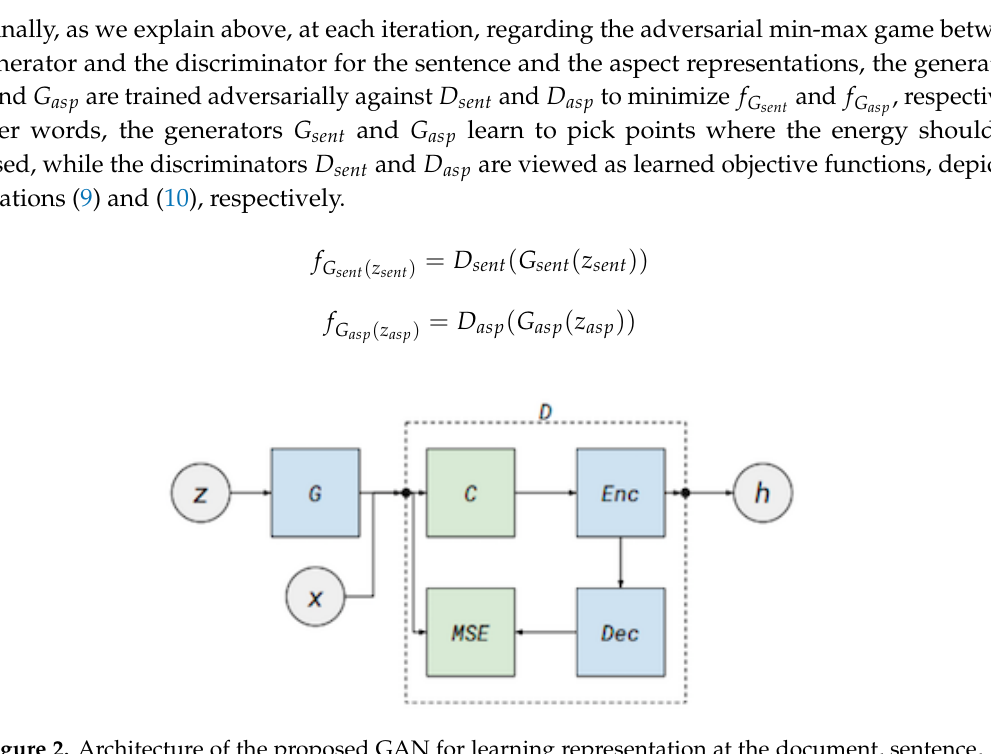
Figure 2. Architecture of the proposed GAN for learning representation at the document, sentence, and aspect level. The network has the following parts: generator G , denoising autoencoder (DAE) encoder Enc , and decoder Dec , a corruption process C , and a discriminator D